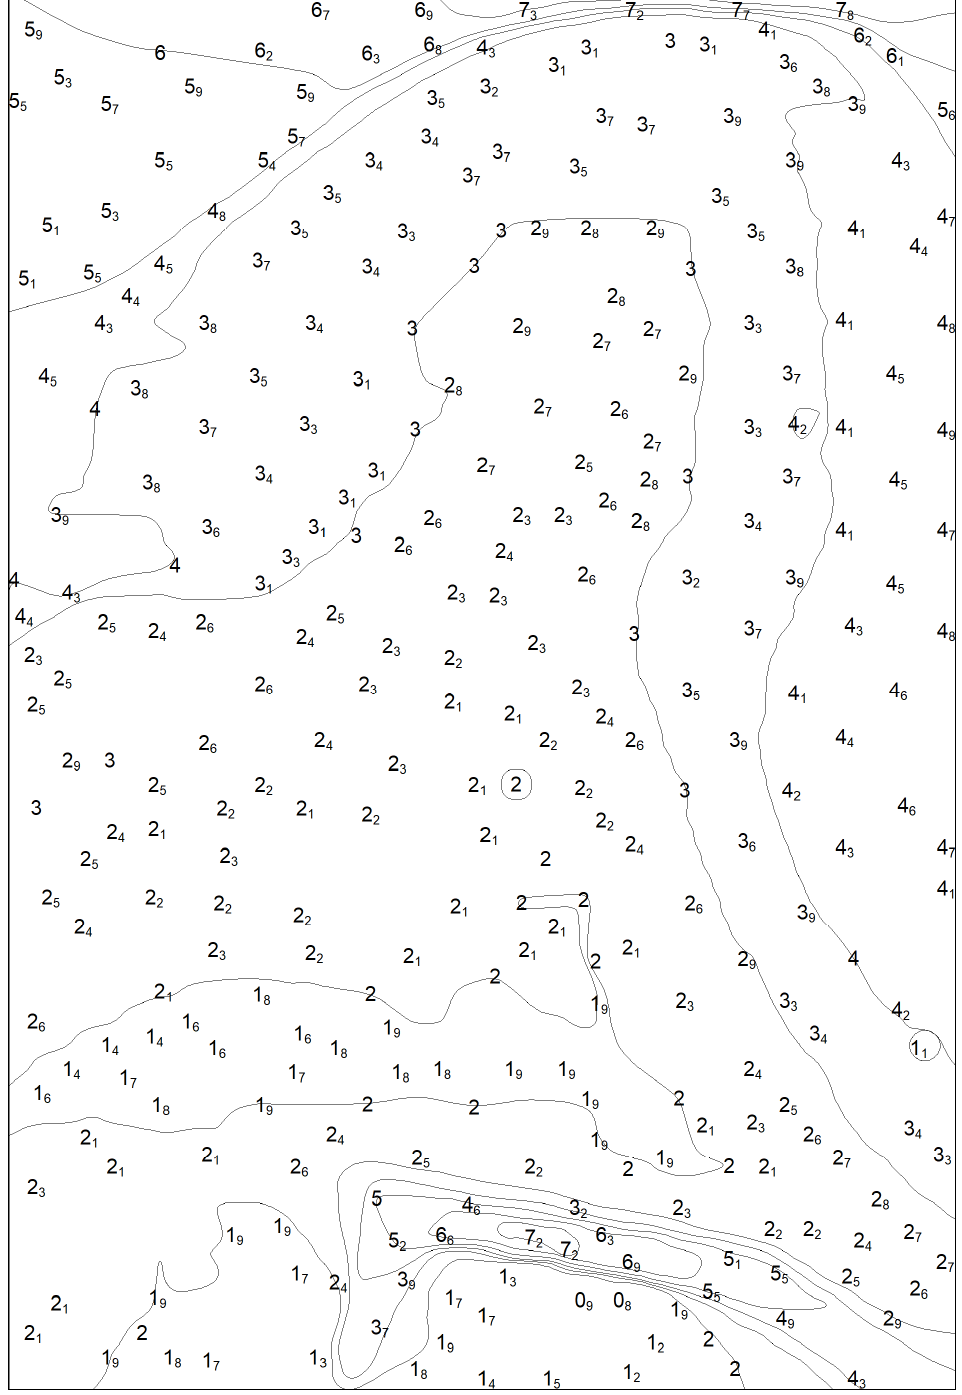
Figure 10. Extract from the 1:10 K scale chart (depth contours 2, 3, 4, 5, 6, 7, 8, 10 m).